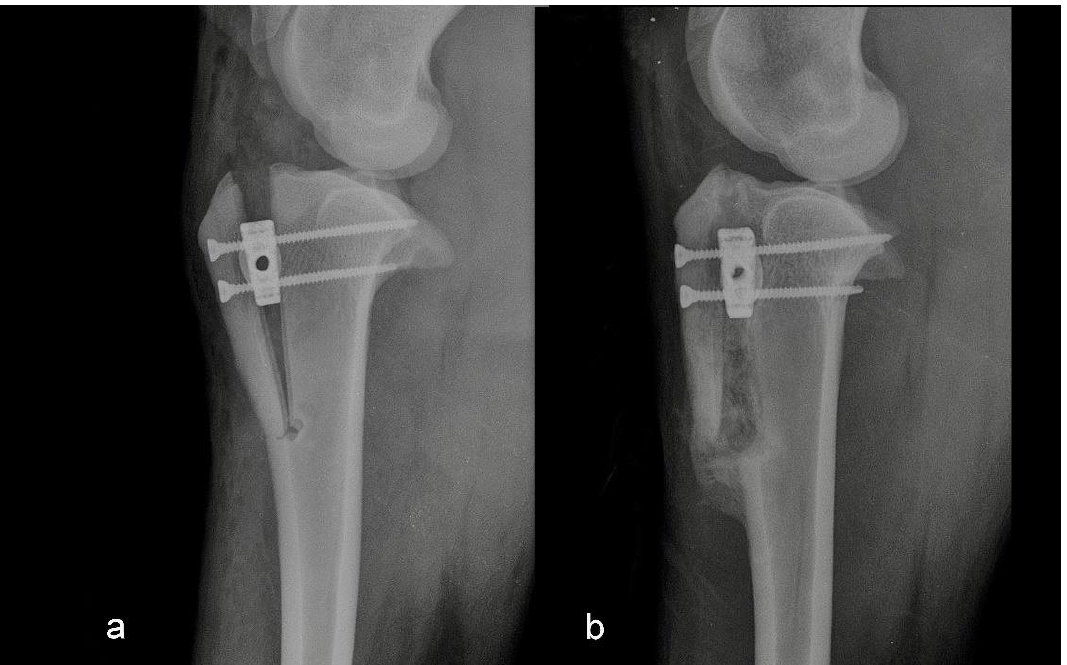
Figure 2. Mediolateral radiograph of the stifle in Group 2 immediately postoperatively ( a ) and at six months postoperatively ( b ). The tibial crest was cracked at the level of the Maquet hole.